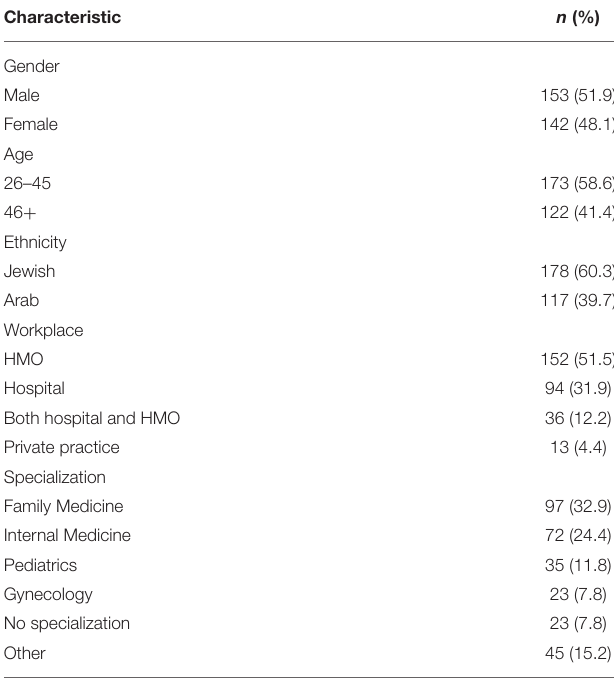
TABLE 1 | Socio-demographic characteristics of the physician ( n =